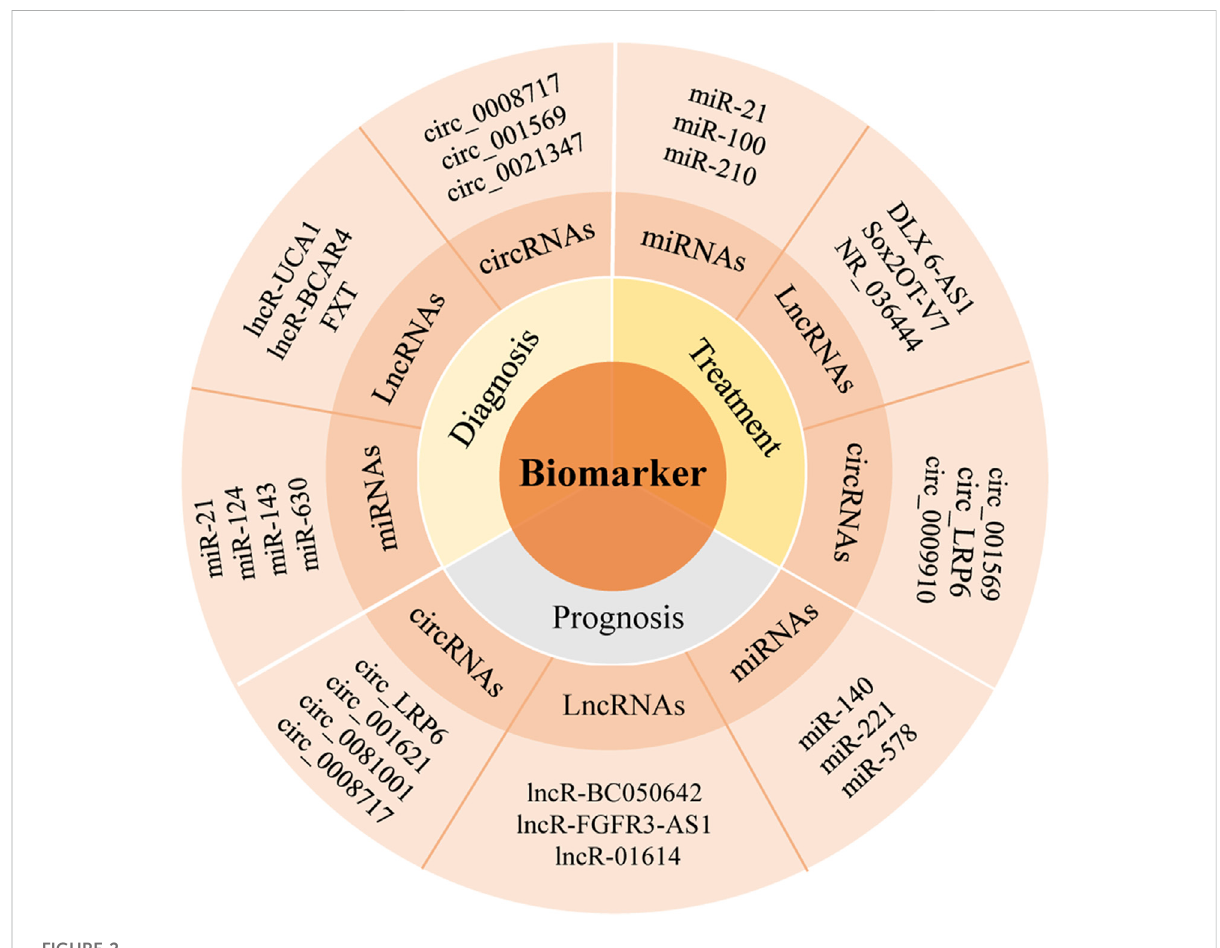
FIGURE 2 The role of partial ncRNAs in